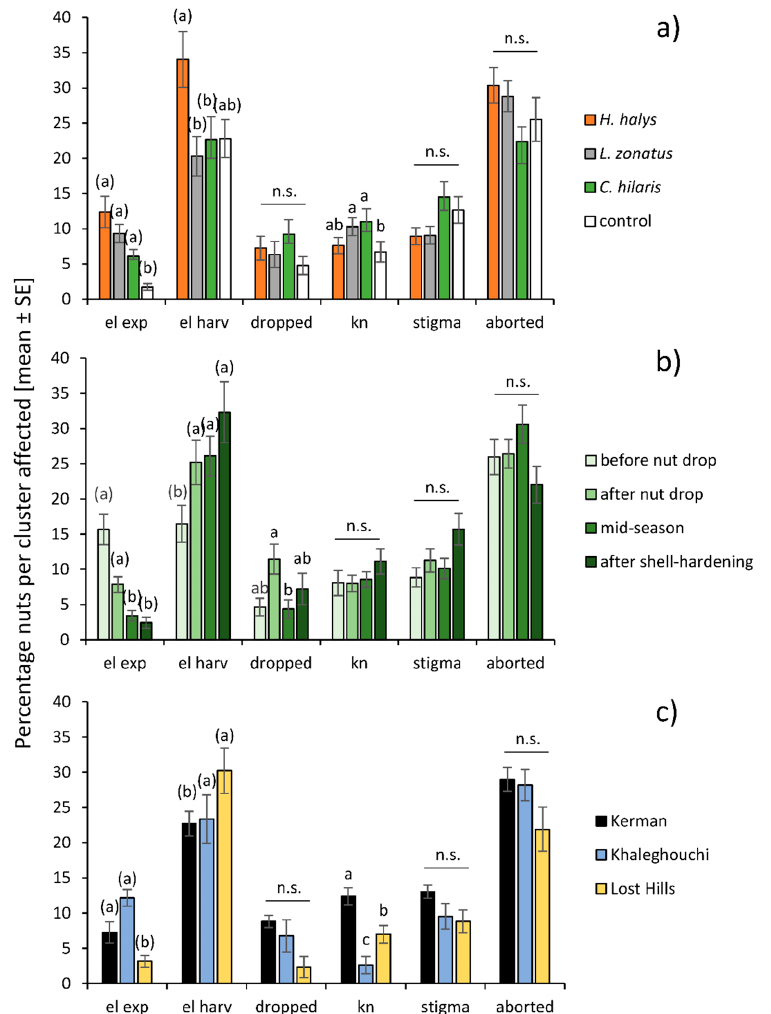
Figure 4. External and internal damage criteria recorded for ( a ) the different insect treatments, ( b ) the pistachio phenology, and ( c ) different pistachio varieties: ‘el exp’ = epicarp lesions recorded immediately after insect exposure, ‘el harv’ = epicarp lesions recorded during harvest, ‘dropped’ = dropped nuts, ‘kn’ = kernel necrosis, ‘stigma’ = fungal symptoms indicating stigmatomycosis, ‘aborted’ = aborted nuts. Treatments were compared within damage criteria for each part of the figure; bars with different letters are significantly different, comparisons without significant differences are headed with ‘n.s.’ (GLMM, Tukey-adjusted mean separations). Letters in parenthesis indicate an involvement in significant interactions (see Figures 2 and